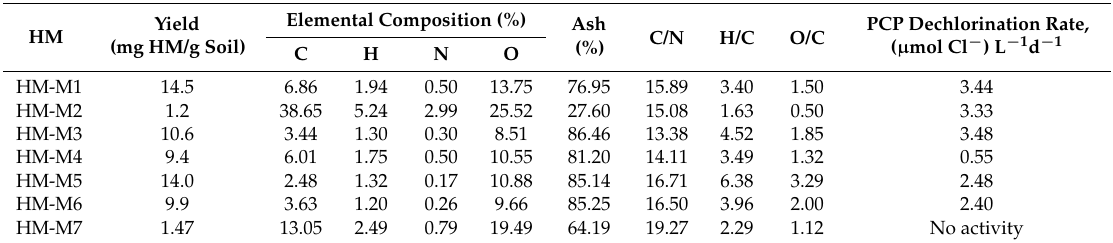
Table 2. Yield, elemental composition of humin (HM) isolated by different methods, and their